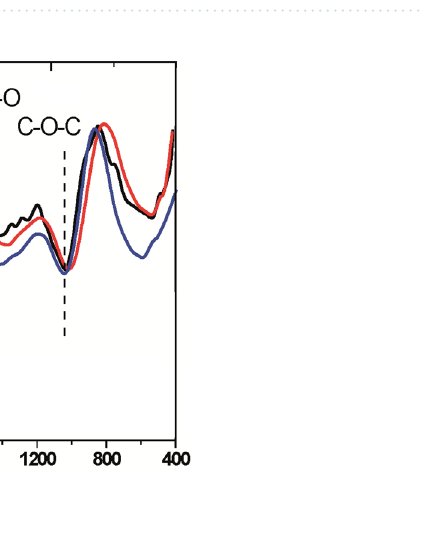
Figure 3. ATR-FTIR of untreated and treated sunflower